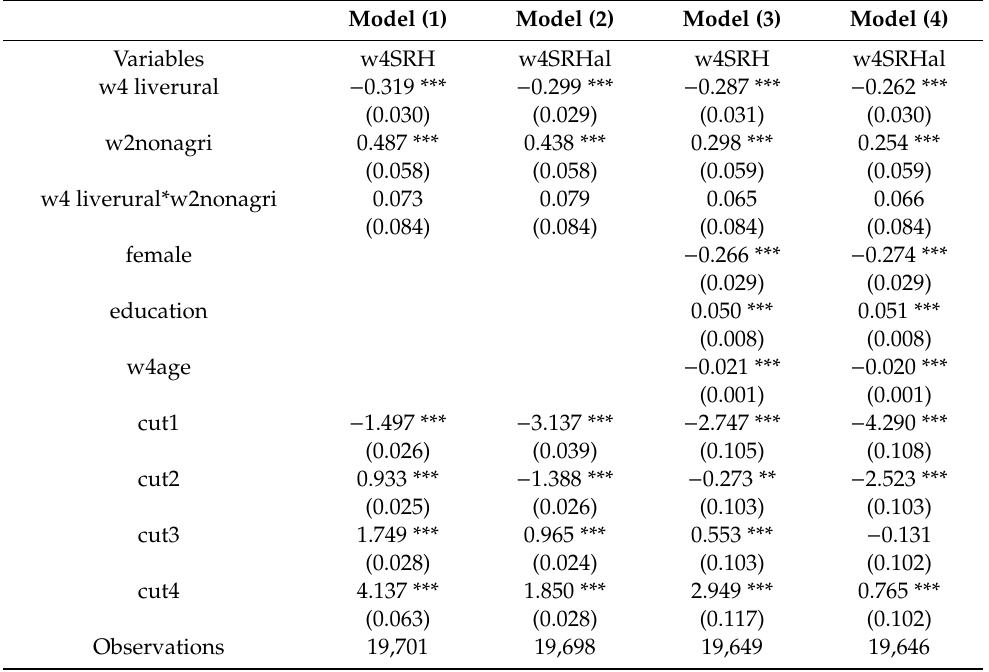
Table 14. Using self-reported health as the dependent variable to explore the salmon bias